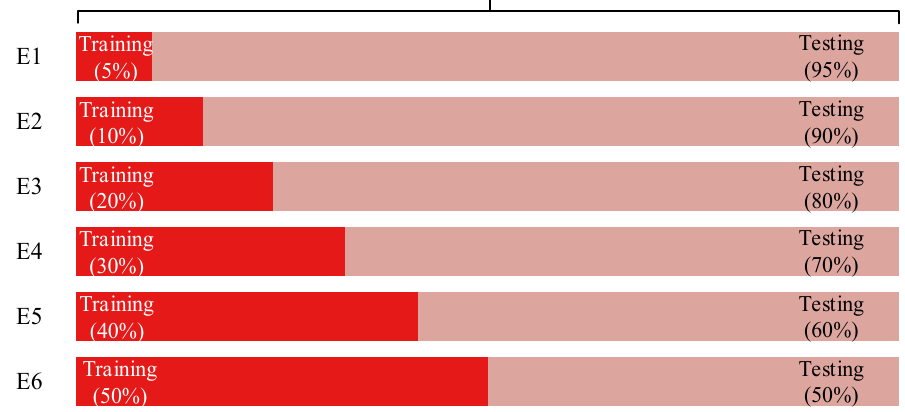
Figure 4. Proportion of data in training set and testing set for the six experiments. E = experiment.